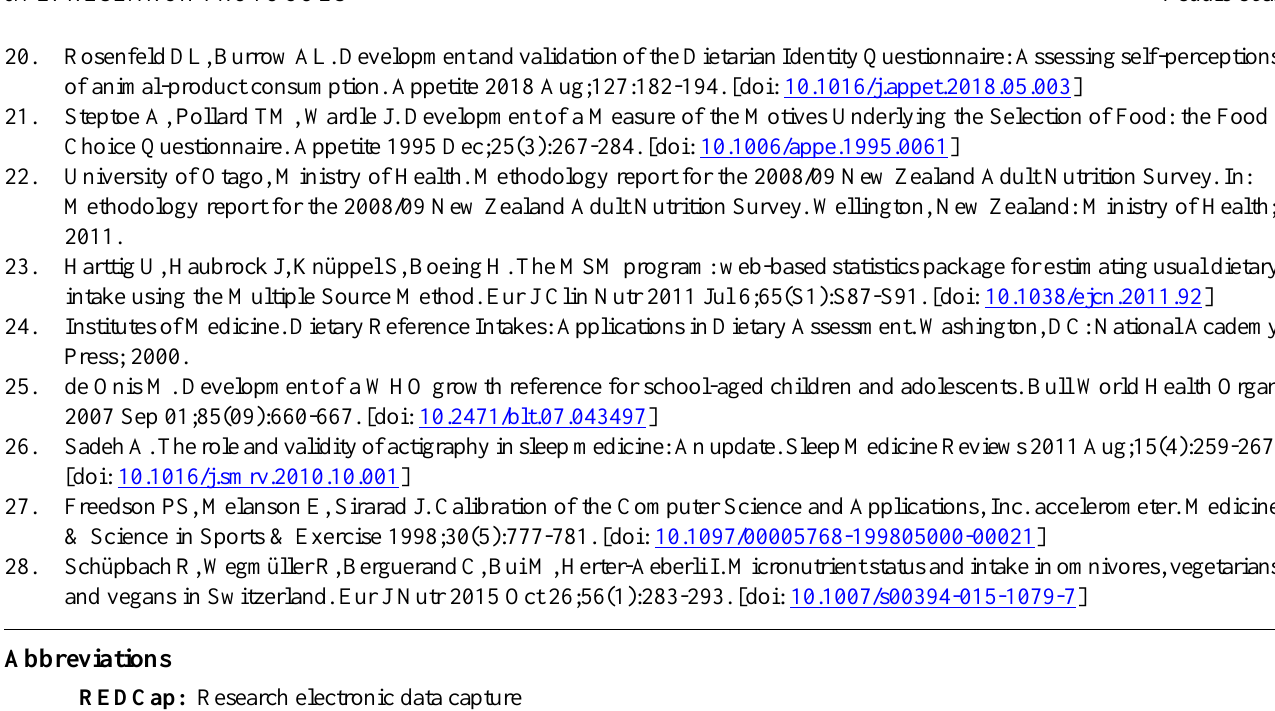
REDCap: Research electronic data